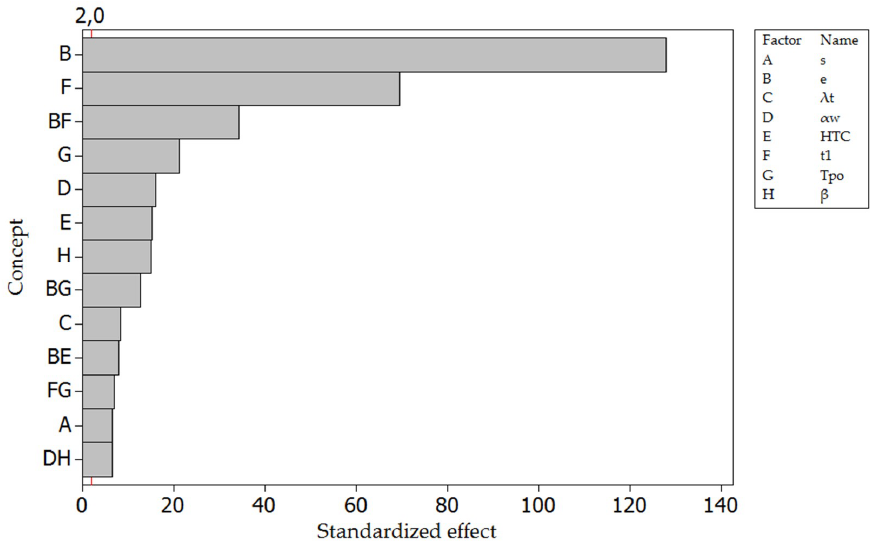
Figure 11. Normal graph of selected standardized effects.